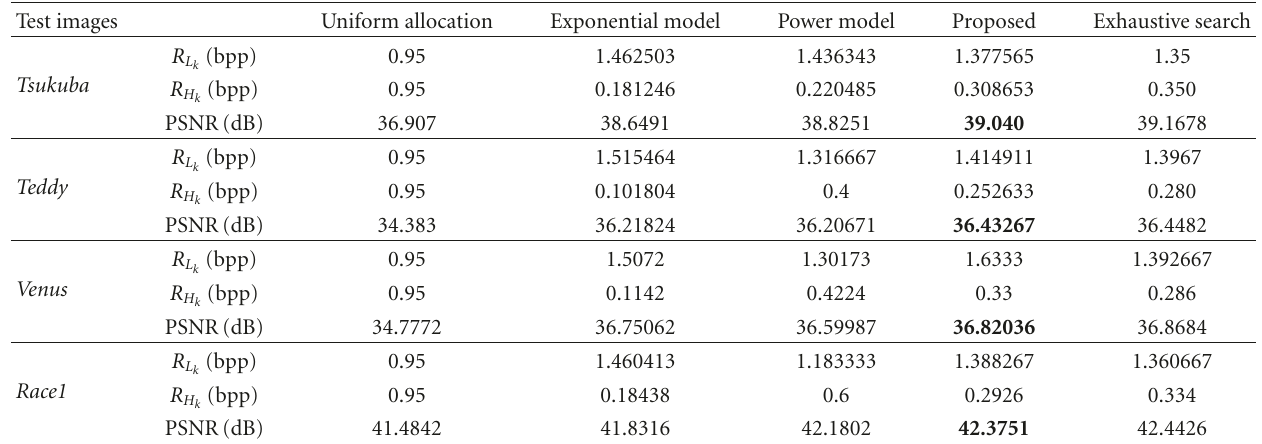
Table 4: Comparison of subband bit allocation at target bit rate